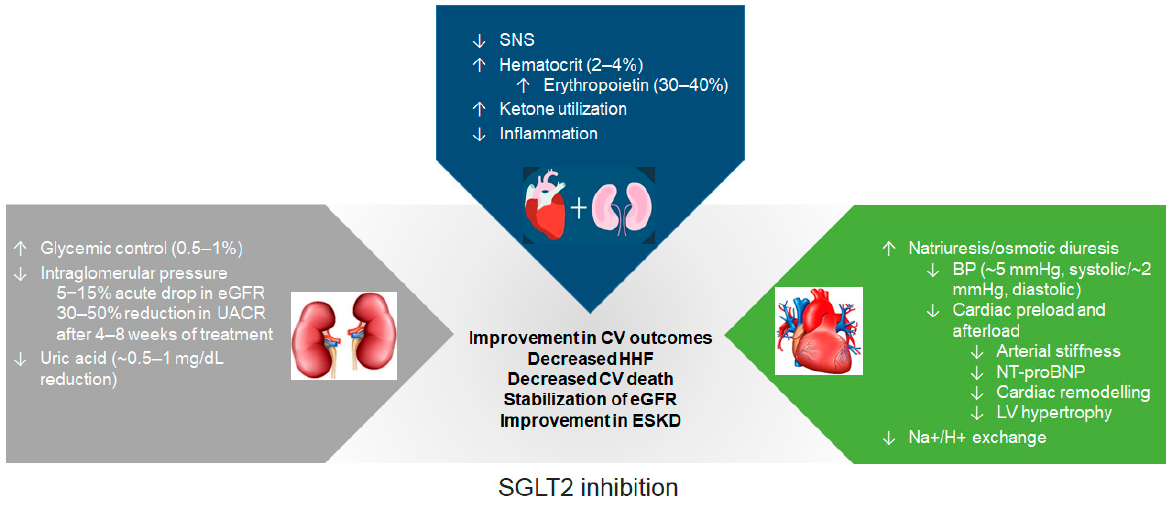
Figure 1. Mechanisms underlying the cardio- and renoprotective effects of SGLT2is. BP, blood pressure; CV, cardiovascular; eGFR, estimated glomerular filtration rate; ESKD, end-stage kidney disease; H + , hydrogen; HHF, hospitalization for heart failure; LV, left ventricular; Na + , sodium; NT- proBNP, N-terminal prohormone of brain natriuretic peptide; SGLT2, sodium-glucose cotransporter-2; SGLT2i, sodium-glucose cotransporter-2 inhibitor; SNS, sympathetic nervous system; UACR, urinary albumin-to-creatinine ratio.